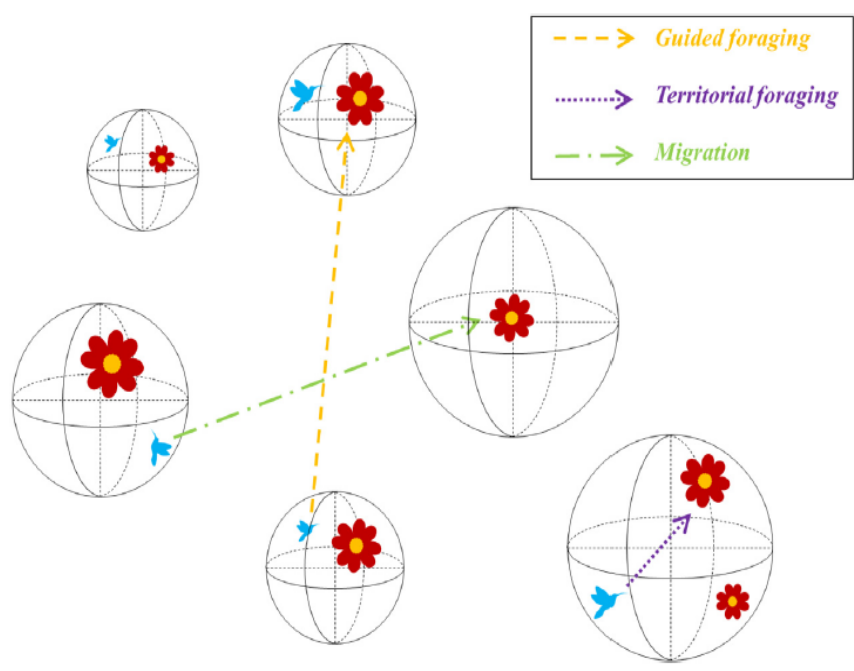
Figure 3. Three foraging behaviors of AHA